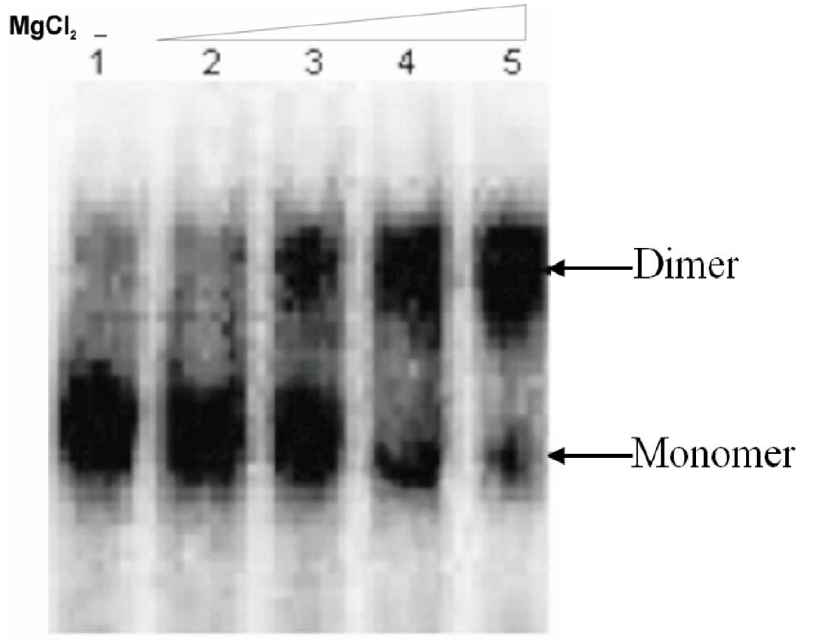
Figure 4. Dimerization efficiency of the HIV-1 RNA (1–447) transcript. The RNA transcripts were incubated in monomer (no MgCl 2 ) and dimerization buffer with varying concentration of MgCl 2 . All samples were analyzed on TBM gels. Lane1: monomer buffer, Lane 2: Dimerization buffer with 1 mM MgCl 2 Lane 3: Dimerization buffer with 2 mM MgCl 2 , Lane 4: Dimerization buffer with 5 mM MgCl 2 , Lane 5: Dimerization buffer with 10 mM MgCl 2.